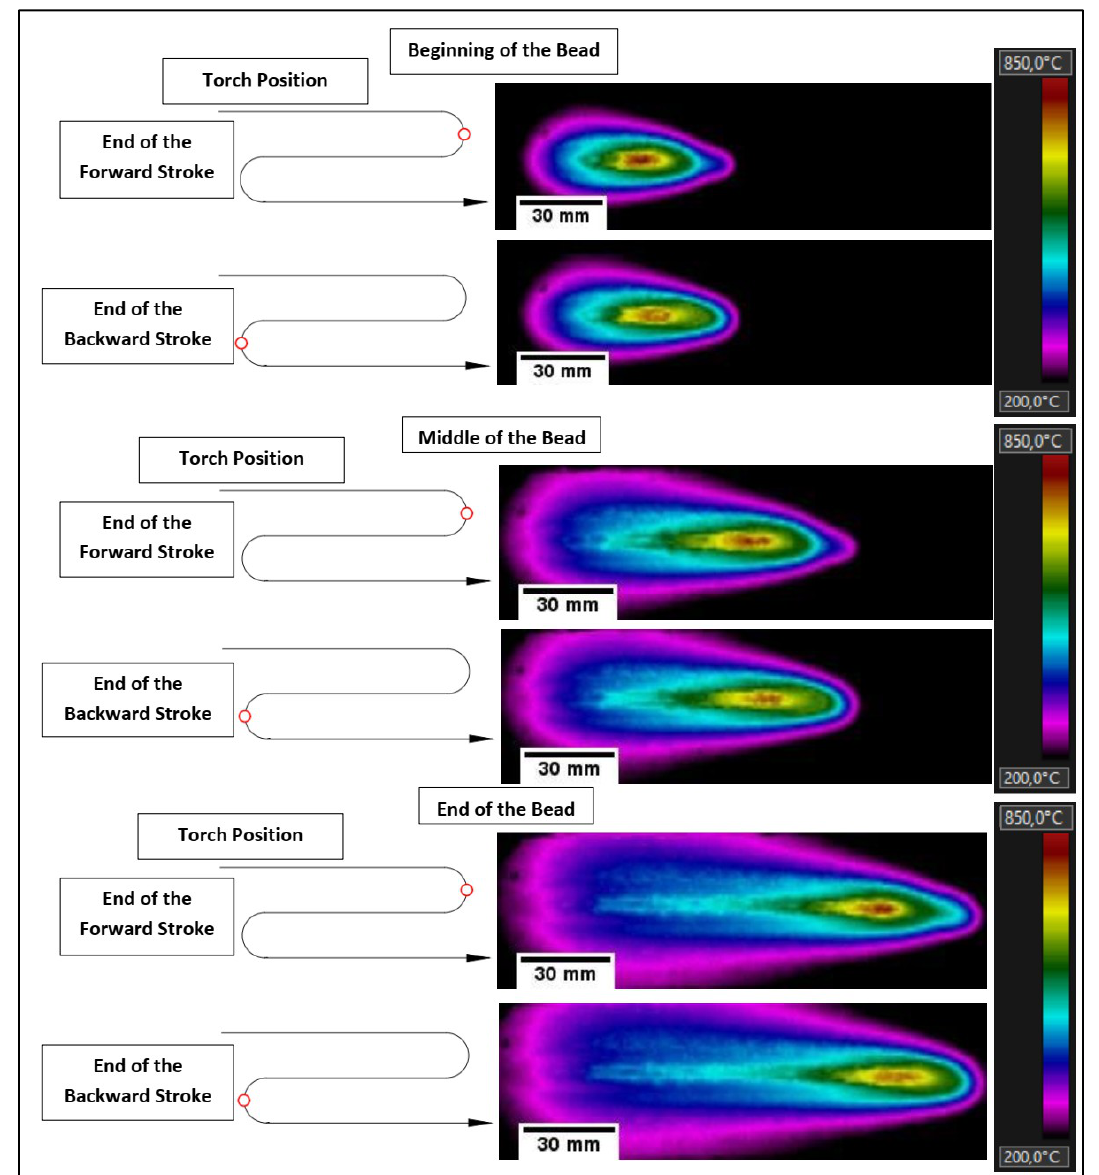
Figure 10. Thermal profile at the plate backside from the deposition T1SB (switchback with F = 30 mm and B = 20 mm) at different welding times (progressively advancing the torch position).